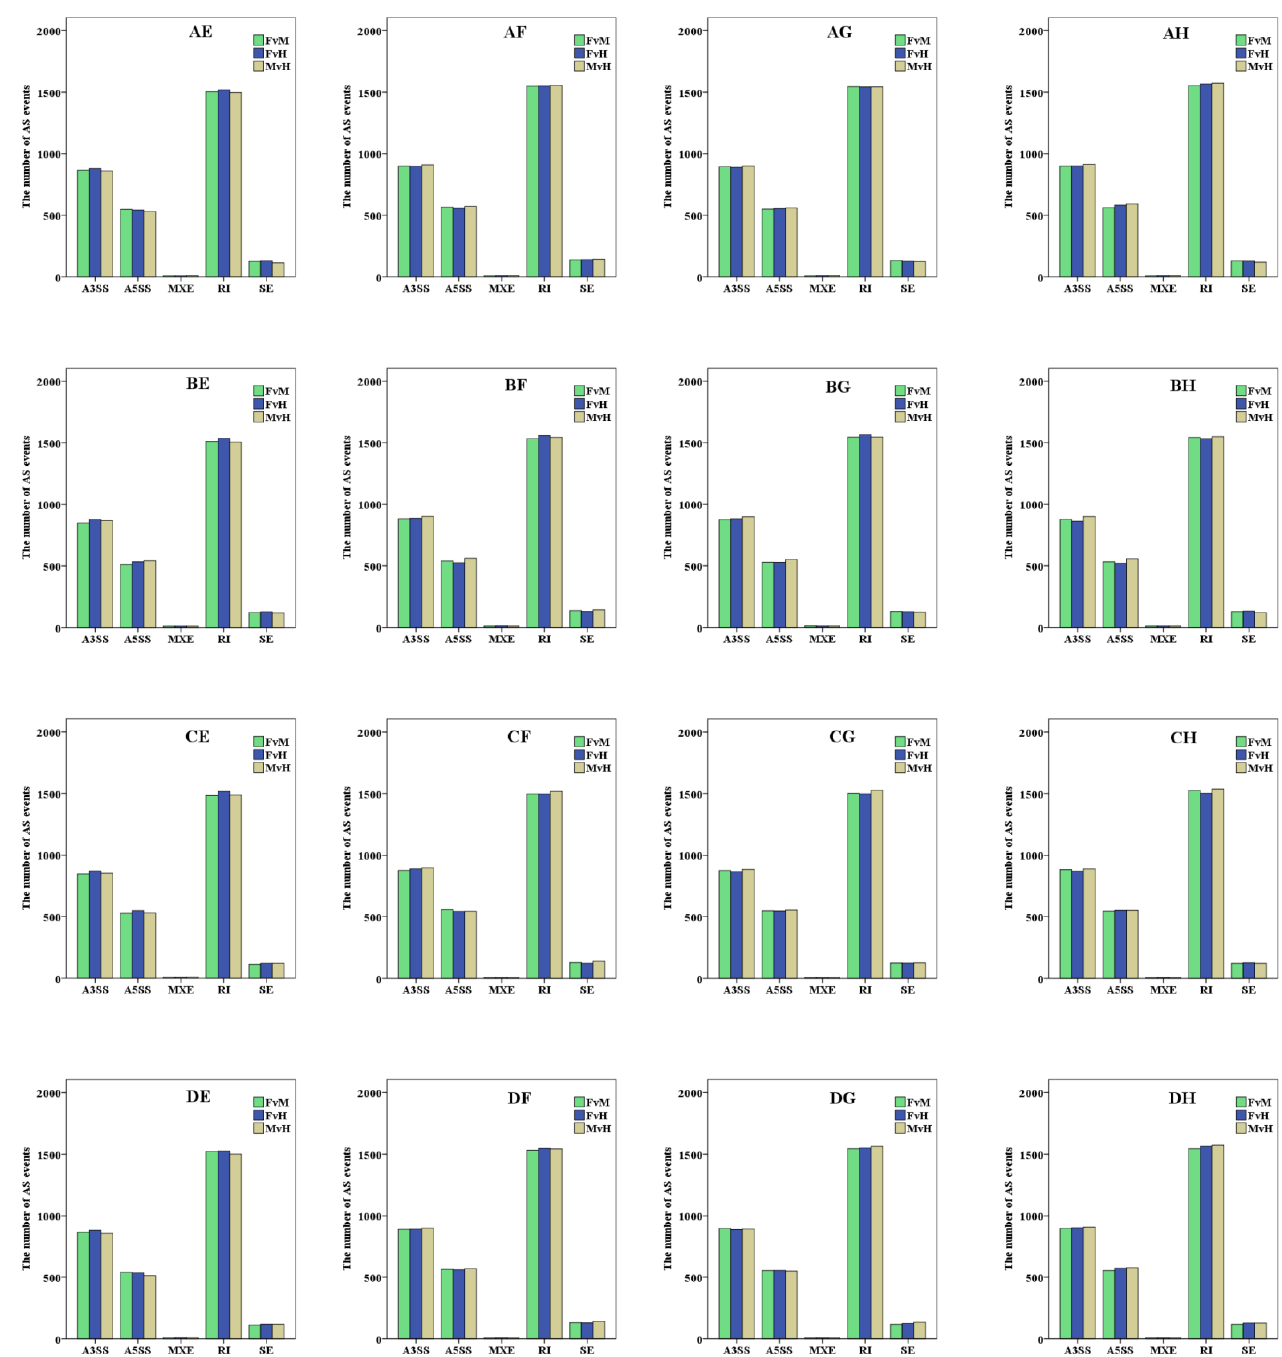
Figure 2. Statistics aboutthe number of alternative splicing (AS) events including skipped exon (SE), alternative 5’ splice site (A5SS), alternative 3’ splice site (A3SS), mutually exclusive exon (MXE), and intron retention (IR).